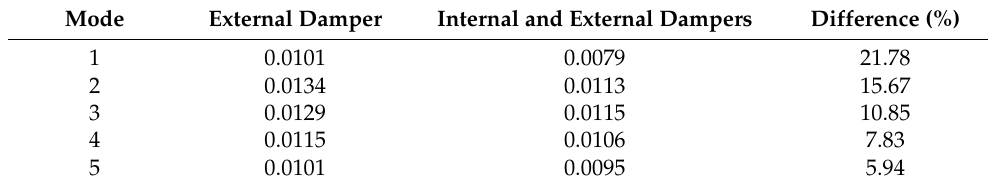
Table 2. Multimode damping ratios of two different cases.